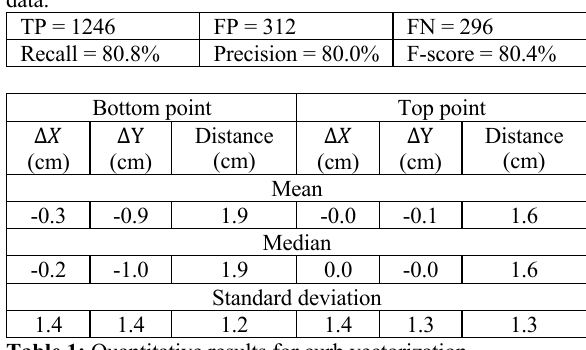
Table 1: Quantitative results for curb vectorization. The mean and median distance between prediction and reference data are less than 2 cm (2 pixels), corresponding to the order of magnitude of the point cloud noise on a solid surface. This also corresponds to the user vectorization accuracy estimated between 1 and 2 pixels.